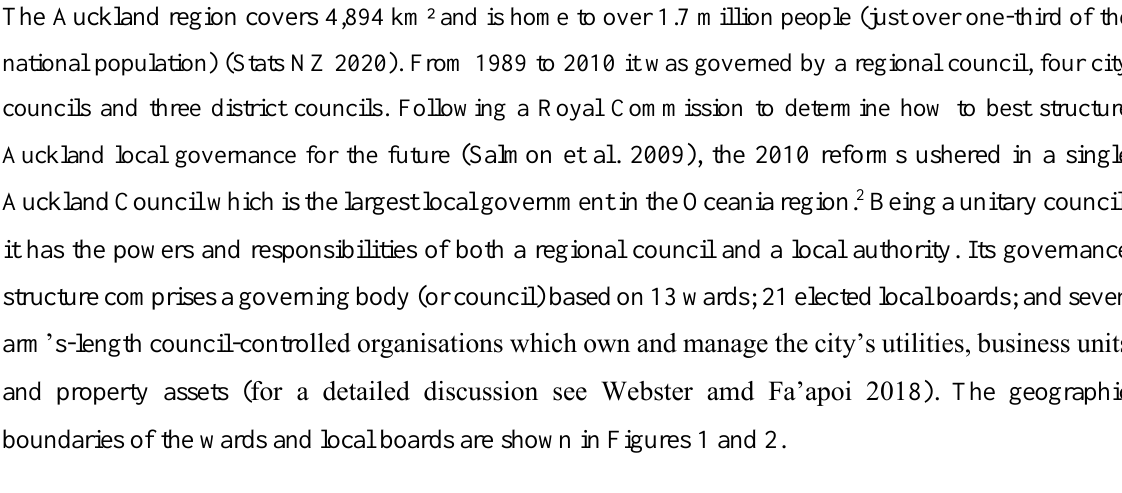
Figure 1: Auckland Council ward